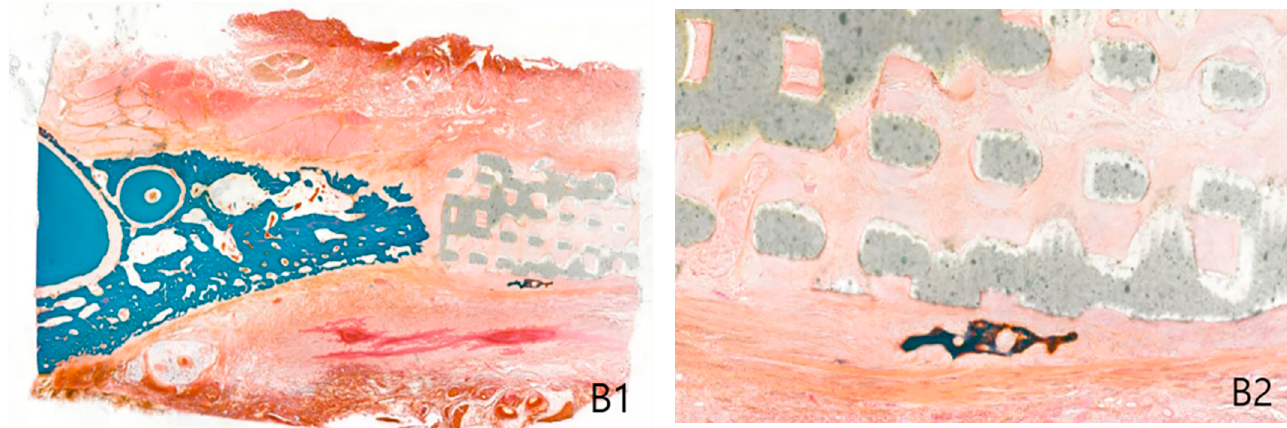
Figure 3. PTE group: biopsy of the 3D printing model of beagle 8 weeks postoperative day (Goldner trichrome stain). ( A ) Anterior marginal area, ( B ) posterior marginal area, (1. original magnification × 20, 2. original magnification × 100).